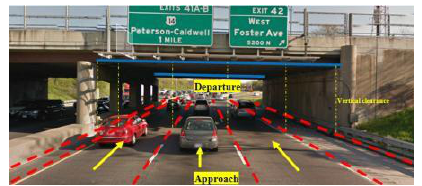
Figure 6. Vertical clearances in the perspective view